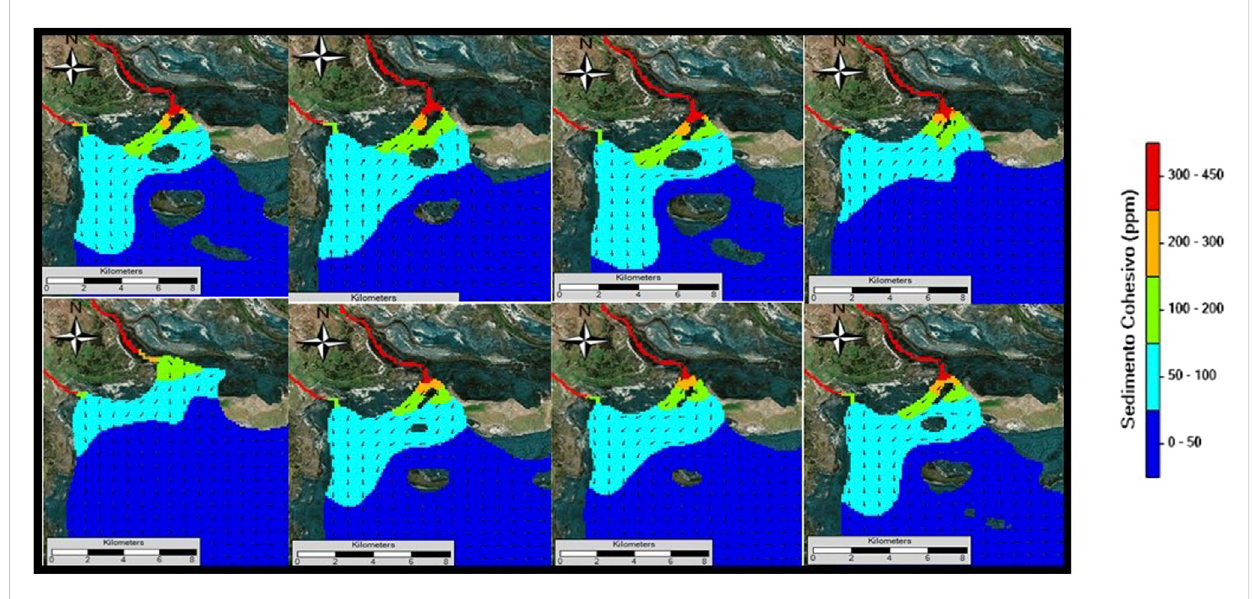
CS discharges of Irrigation network over the sea- 2019/01/03 (00 – 21 h).